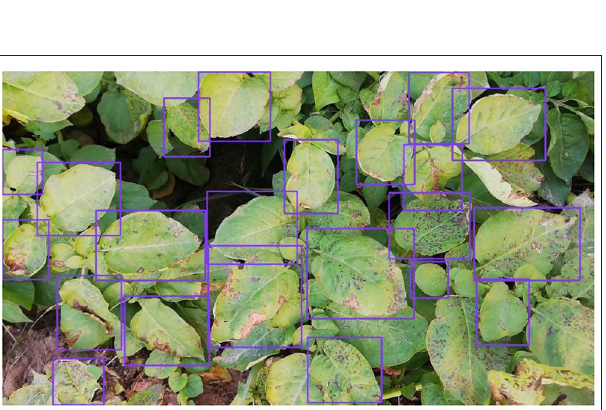
FIGURE A3 | Prediction of the best model trained on the PFD dataset and live labeling of the sample